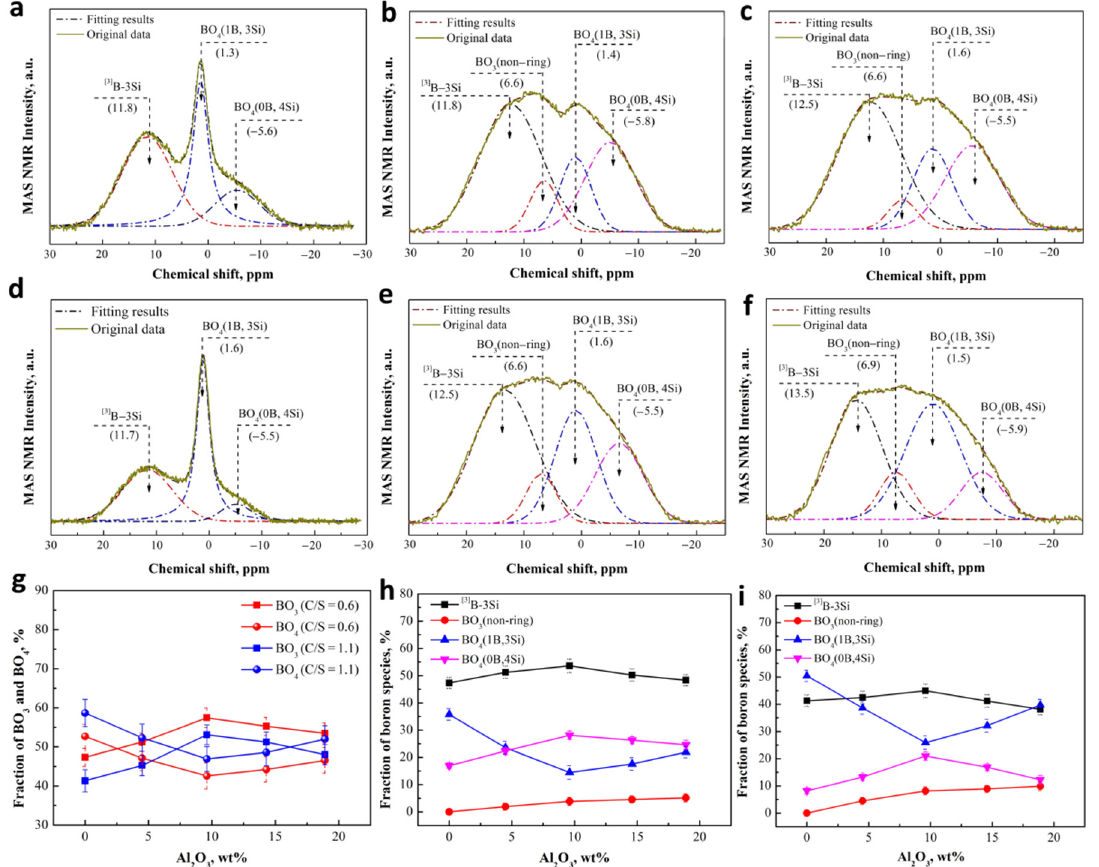
Figure 6. Solid state 11 B spectra for CaO − SiO 2 − Al 2 O 3 slags at room temperature with 0 Al 2 O 3 and 0.6 of basicity ( a ); 9.62 wt% Al 2 O 3 and 0.6 of basicity ( b ); 19.25 wt% Al 2 O 3 and 0.6 of basicity ( c ); 0 Al 2 O 3 and 1.1 of basicity ( d ), 9.16 wt% Al 2 O 3 and 1.1 of basicity ( e ); 18.73 wt% Al 2 O 3 and 1.1 of basicity ( f ), ( g ) Fraction of BO 3 and BO 4 as a function of basicity and Al 2 O 3 contents based on Raman spectroscopy of the CaO − SiO 2 − Al 2 O 3 slag, Fraction of B species as a function of Al 2 O 3 contents based on Raman spectroscopy of the CaO − SiO 2 − Al 2 O 3 slag at 0.6 of basicity ( h ) and 1.1 of basicity ( i ).